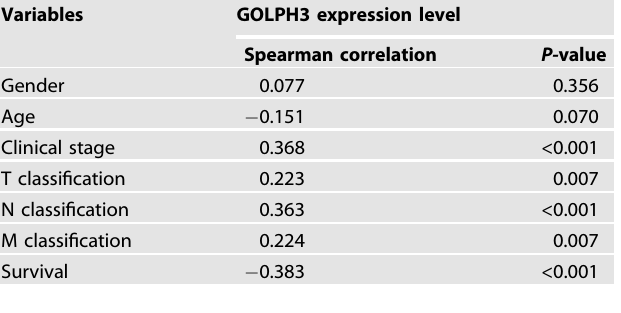
Table 3. Spearman correlation analysis between GOLPH3 expression and clinical pathologic factors. Variables